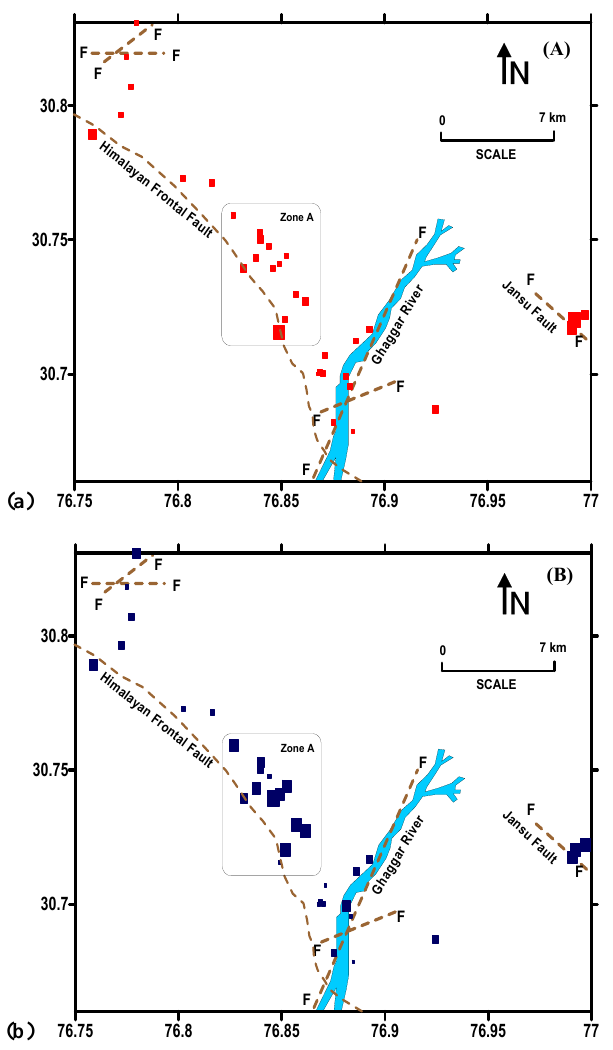
Fig. 4. Map of Nadha and adjoining areas in the present study show- ing tectonic features (faults), drainage pattern and the variation in radon concentration. The size of solid red rectangles corresponds to Fig. 4b: Map of Nadha and adjoining areas in the present study showing tectonic (a) radon concentration varying from 4 to 54kBq/m 3 ; features (faults), drainage pattern and the variation in helium concentration. The size (b) helium concentration varying from 5.24 to of solid blue rectangles corresponds to helium concentration varying from 5.24 to 5.38 ppm.